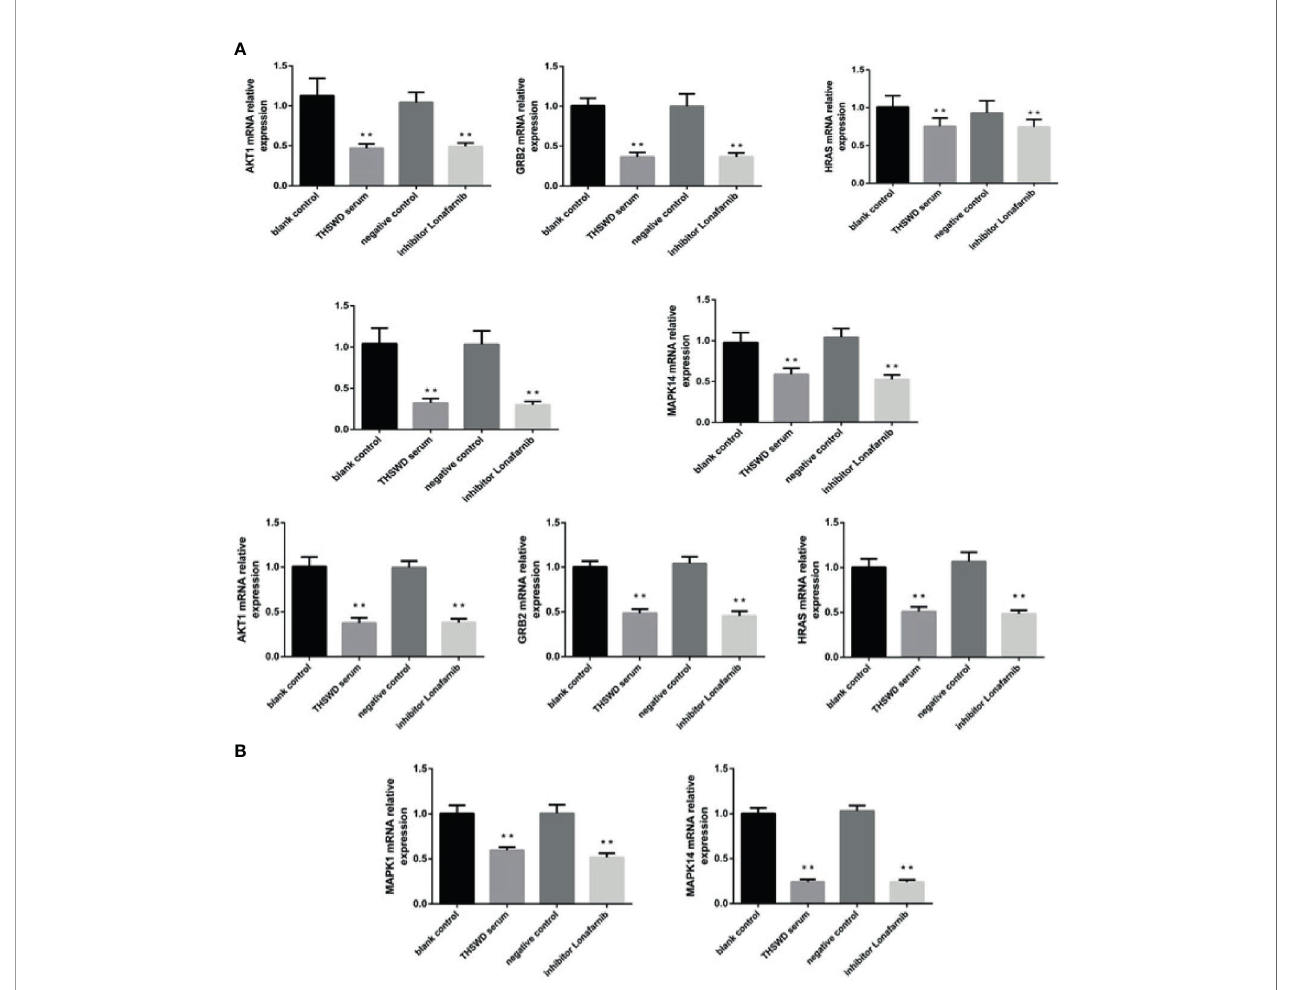
FIGURE 10 | The expression of breast cancer-related genes in MCF-7 and MDA-MB-231 cells after treatment with THSWD (A) MDA-MB-231 (B) MCF-7. **P < 0.01 compared with blank control